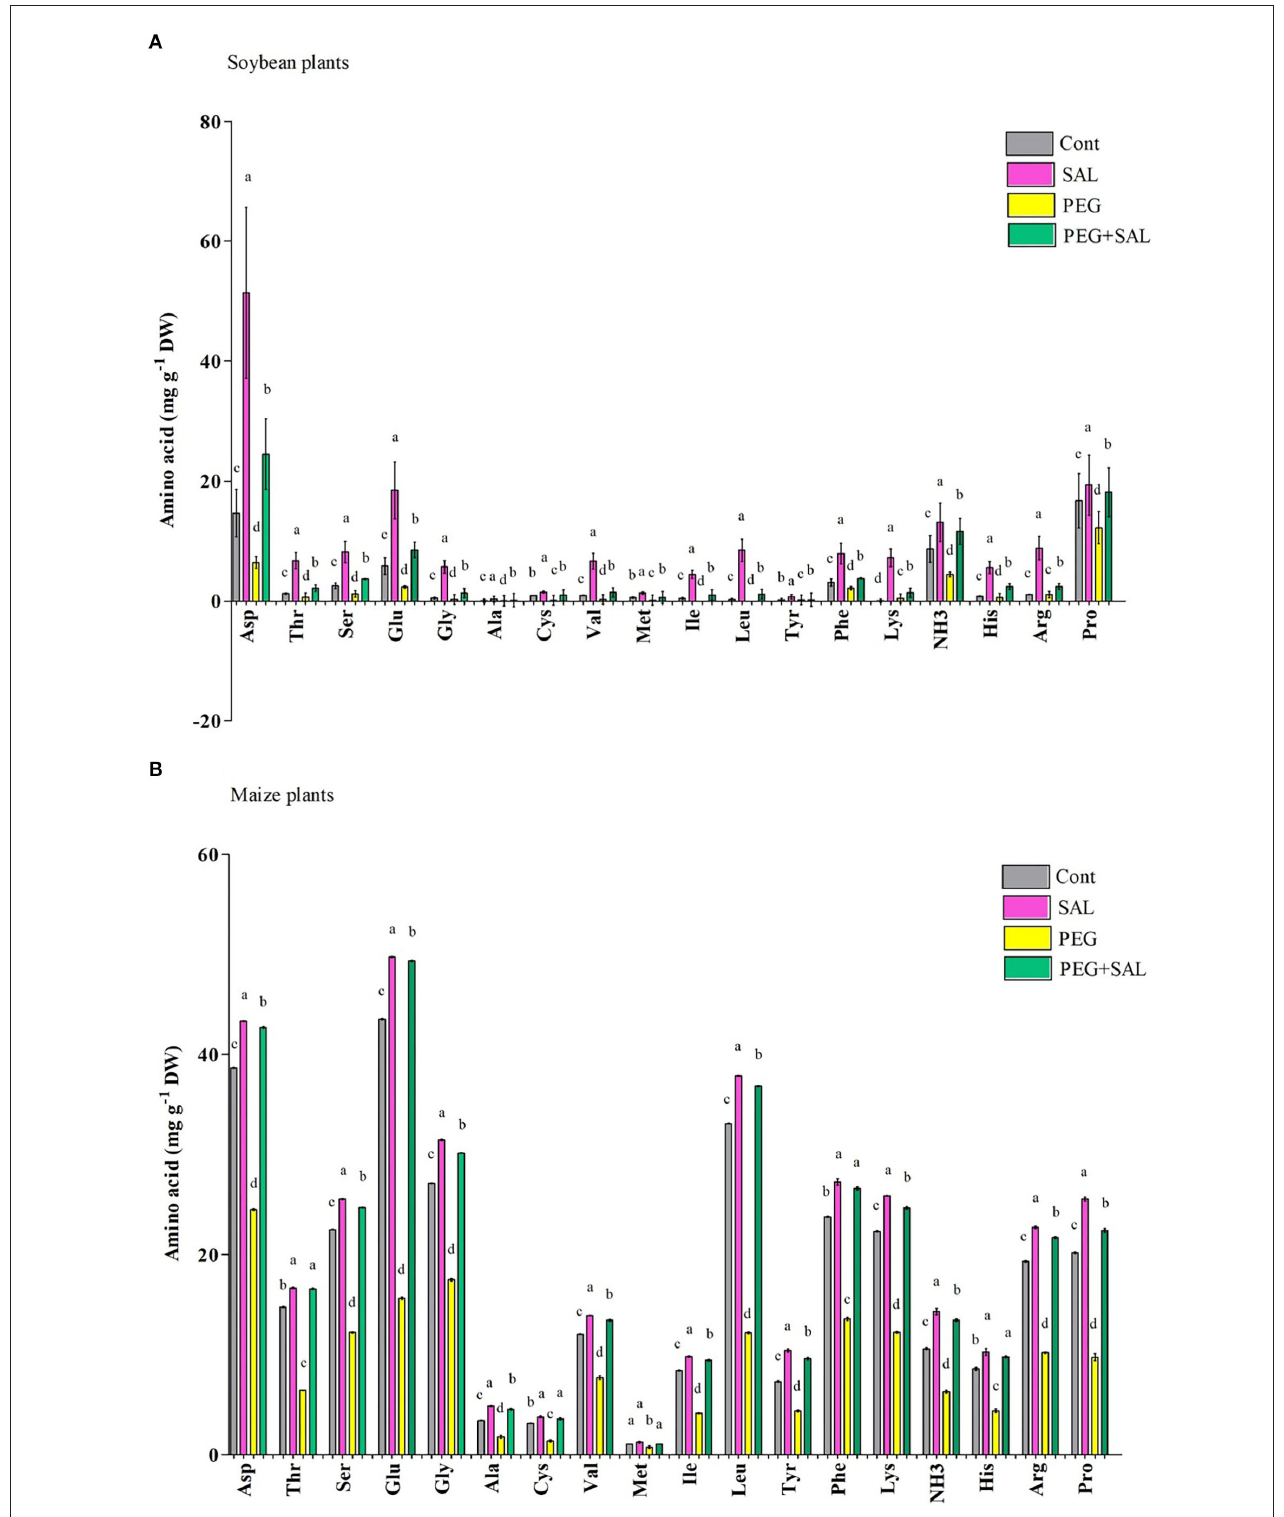
FIGURE 4 | Effect of salvianolic acid application on amino acid content in leaves of soybean and maize grown under normal and stress conditions 8 days post-treatment (A,B) . Treatments: Cont (control), SAL (0.1 µ M salvianolic acid), SAL (1 µ M salvianolic acid), PEG (25% polyethylene glycol), SAL (0.1 µ M salvianolic acid) + PEG (25% polyethylene glycol), and SAL (1 µ M salvianolic acid) + PEG (25% polyethylene glycol). Values show the mean ± SE ( n = 6) and significant differences at p < 0.05 (Tukey’s test). Bars with different lowercase letters are significantly different from each other.